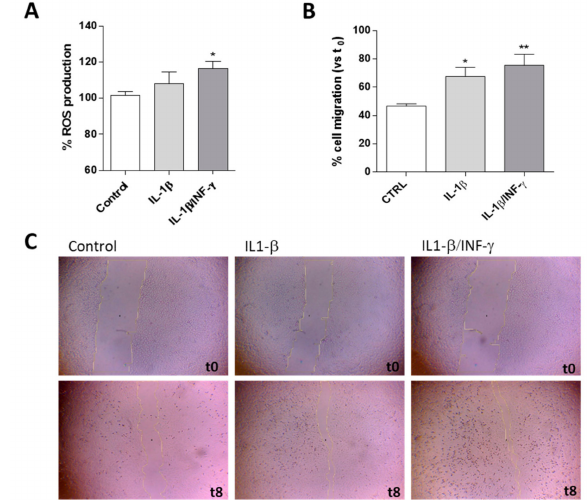
Figure 2. E ff ects of IL-1 β or IL1- β / INF- γ on C20 cell ROS production and migration ability. C20 cells were treated with IL-1 β (20 ng / mL) or IL1- β / INF- γ (100 ng / mL / 50 ng / mL) for 24 h. ( A ) ROS generation was quantified and reported as a percentage with respect to untreated cells (Control). Each bar represents the mean ± SEM of three replicates from two independent experiments. ( B ) C20 cells were treated as reported and the percentage of gap closure with respect to the evaluated t 0 . The data are presented as the mean values ± SEM of at least two independent experiments performed in duplicate (4 ·×· magnification). ( C ) Representative images of the scratch wounds at t = 0 h and t = 8 h are shown. The significance of the di ff erences was determined by one-way ANOVA, followed by Bonferroni’s post-test: * p ≤ 0.05, ** p ≤ 0.01 vs.